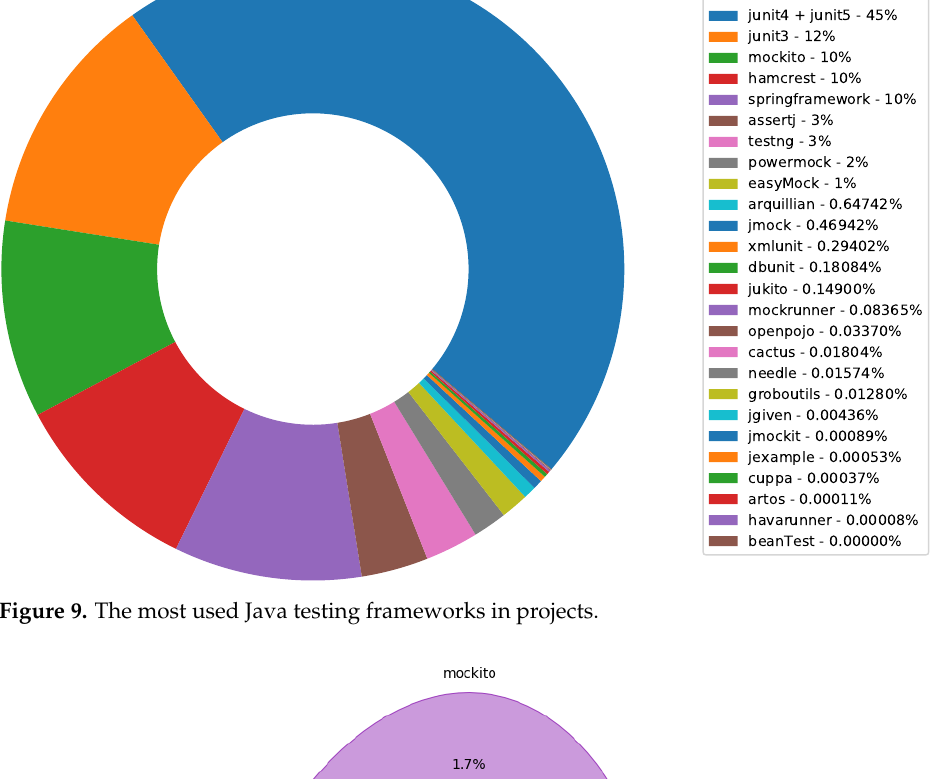
Figure 9. The most used Java testing frameworks in projects.